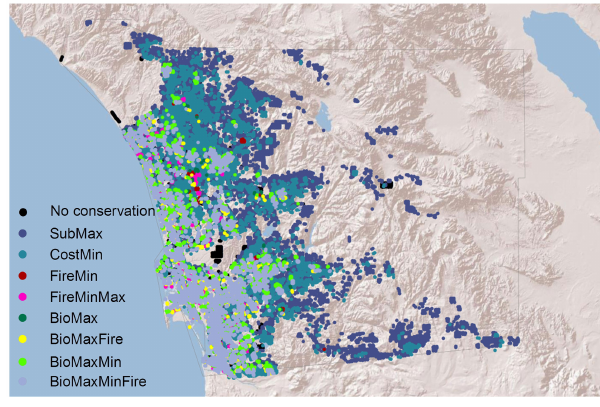
Fig. 3 . Map illustrating newly developed structures in year 2034 for all conservation selection